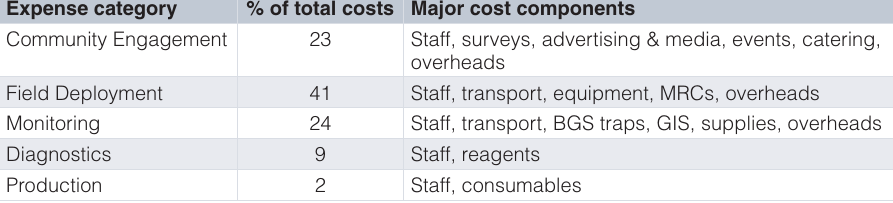
Table 4. Costs by major activity class for entire deployment.